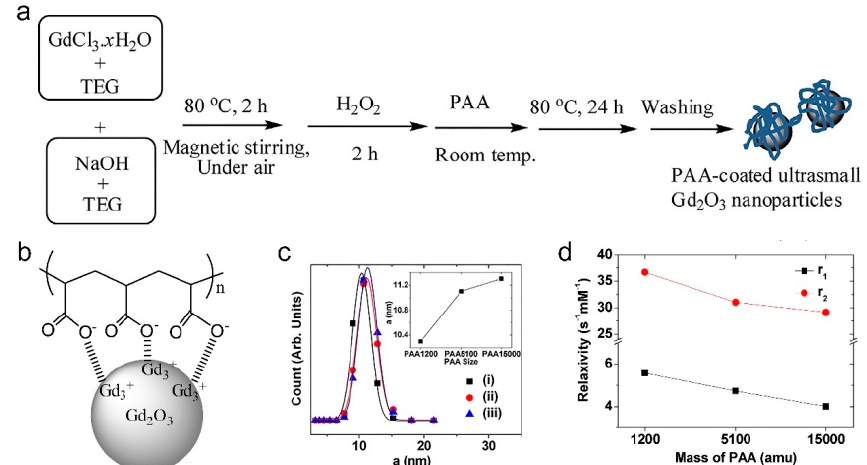
Figure 6. ( a ) Schematic representation of the one-pot synthesis of polyacrylic acid (PAA) coated Gd